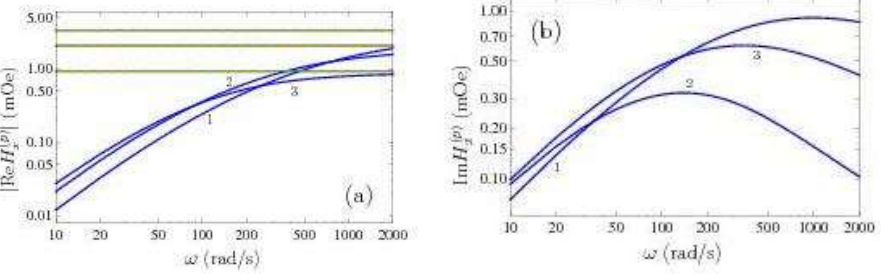
Figure 6. The magnitude of the real part ( a ) and the imaginary part ( b ) of the lateral component of monochromatic magnetic field reflected from the copper plate computed using the Drude model at the dipole height of 1 cm above a plate is shown by the solid lines labeled 1, 2, and 3 as the function of oscillation frequency at separations from the magnetic dipole equal to 10, 20, and 30 mm, respectively. The three solid lines overlapping with the dashed ones counted from top to bottom ( a ) are computed using the plasma and spatially nonlocal models at separations of 10, 20, and 30 nm,